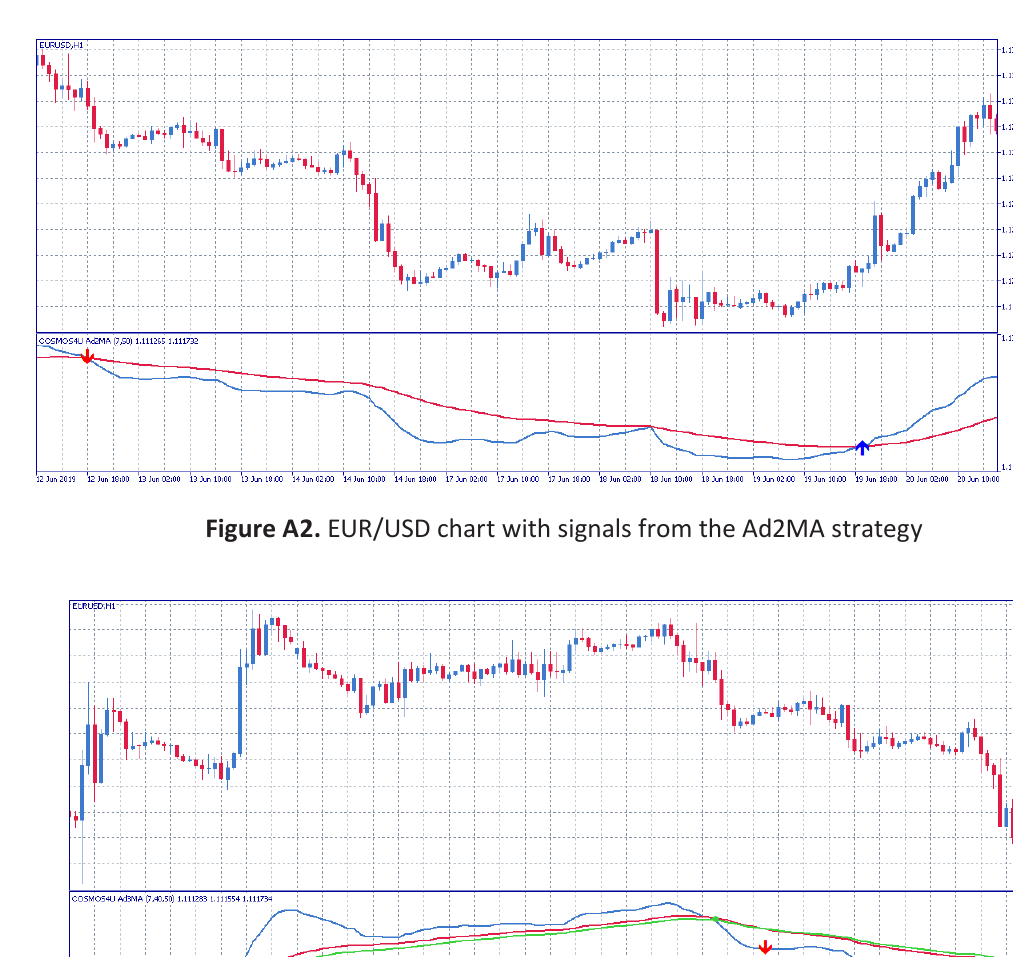
Figure A1. EUR/USD chart with signals from the Ad1MA strategy